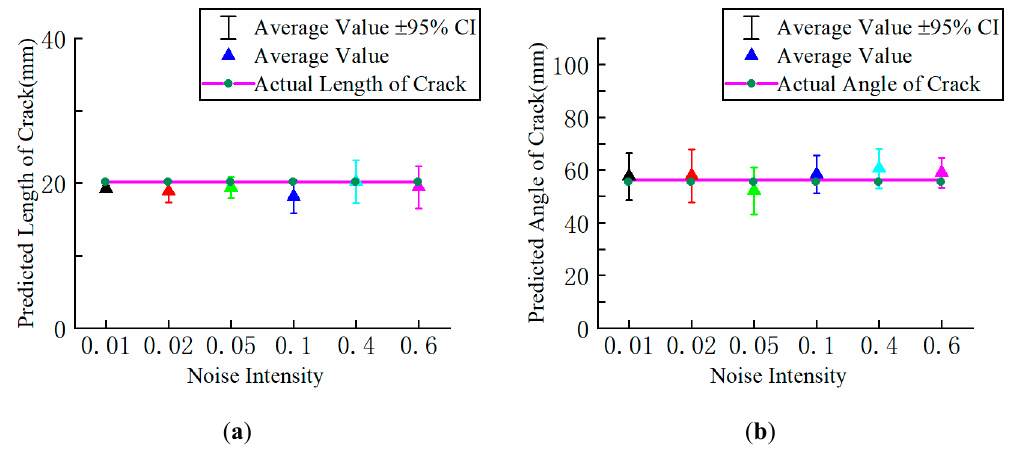
Figure 15. Predicted average of cracks at different noise intensities: ( a ) length prediction; ( b ) angle prediction.